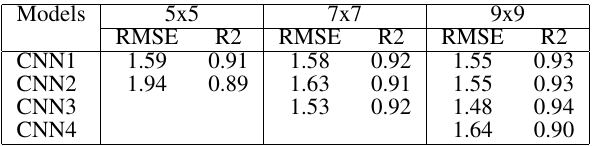
Table 6. Accuracy assessment of SDB using CNN with different number of